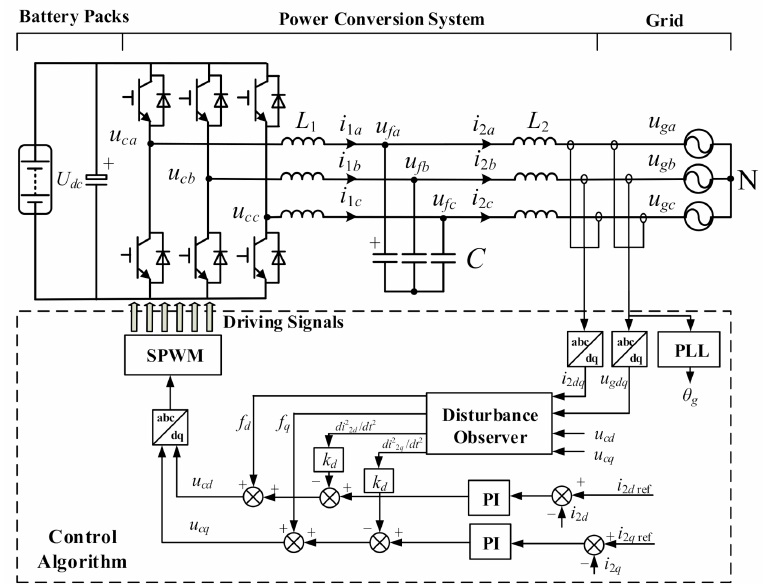
Figure 1. Basic block diagram and control principle of battery energy storage